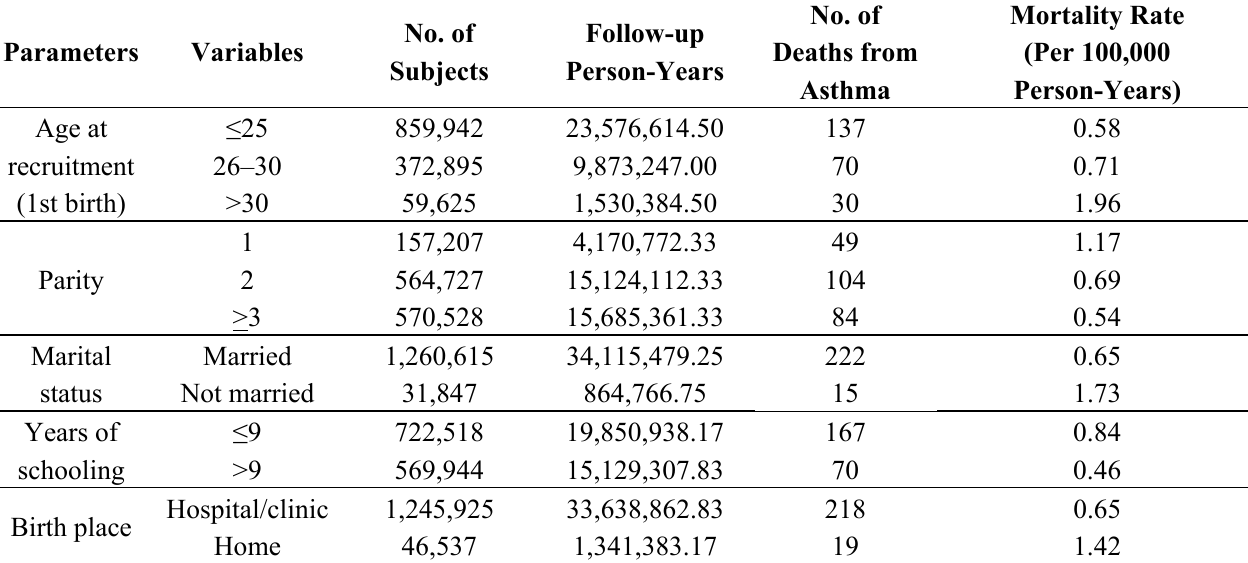
Table 1. Demographic characteristics of the study cohort.